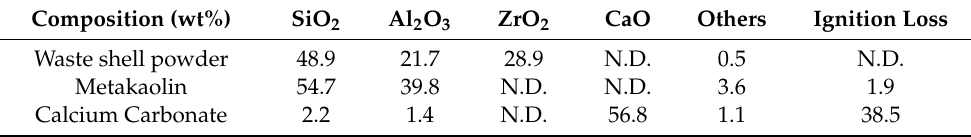
Table 1. Chemical compositions of waste ceramic shell, metakaolin and calcium